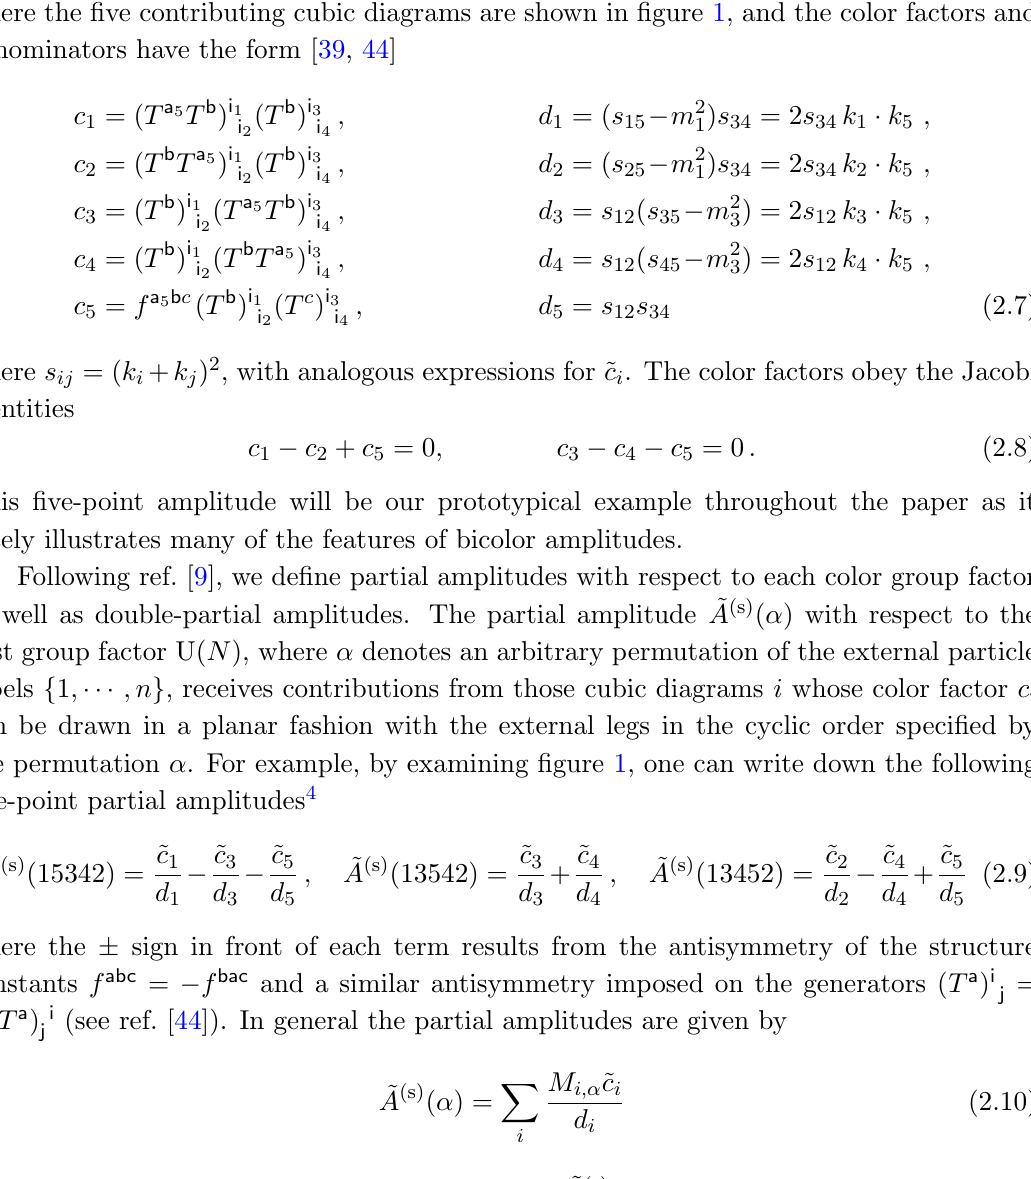
Figure 1 . Cubic diagrams i = 1 through 5 for A bicolor scalars whereas curly lines denote biadjoint